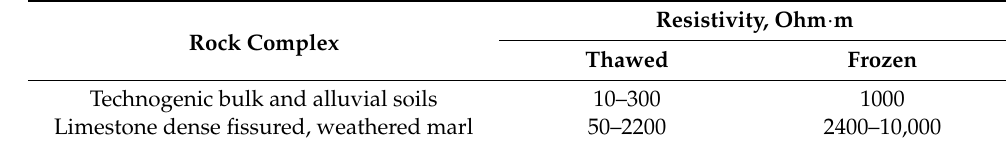
Resistivity, Ohm ·